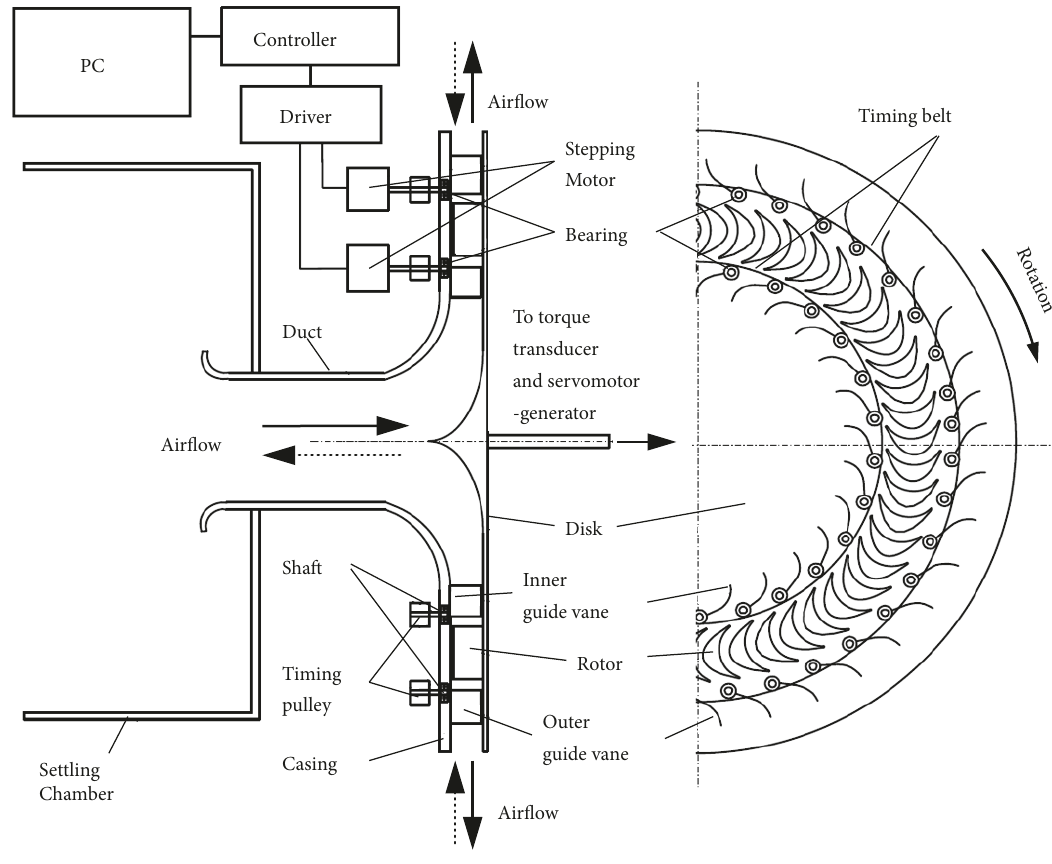
Figure 6: Radial turbine with pitch-controlled guide vanes.